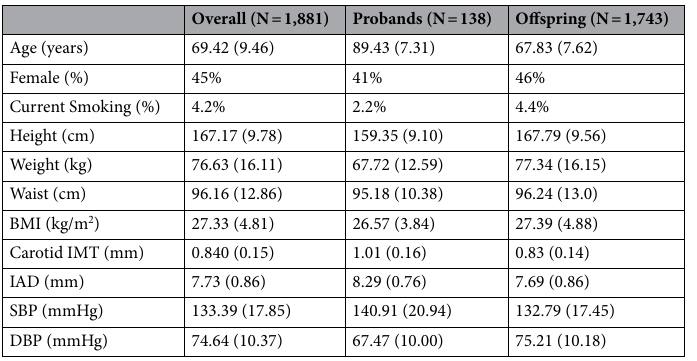
Table 1. Characteristics of LLFS Participants. *Characteristics shown as mean (SD) or frequency, as appropriate.